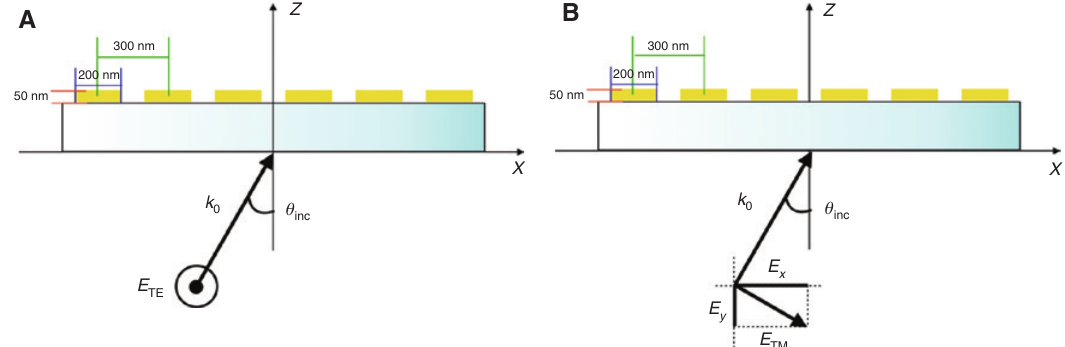
Figure 3: Geometrical configurations utilized during the angle-resolved extinction measurements, in case of TE (A) and TM (B) polarization of the exciting light.